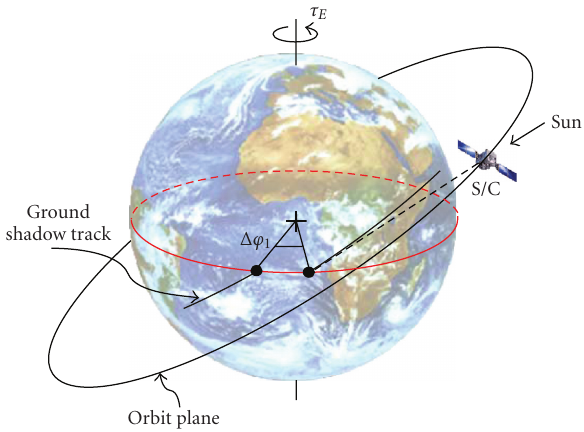
Figure 8: The e ff ect of the Earth’s rotation around its axis on shadow track.